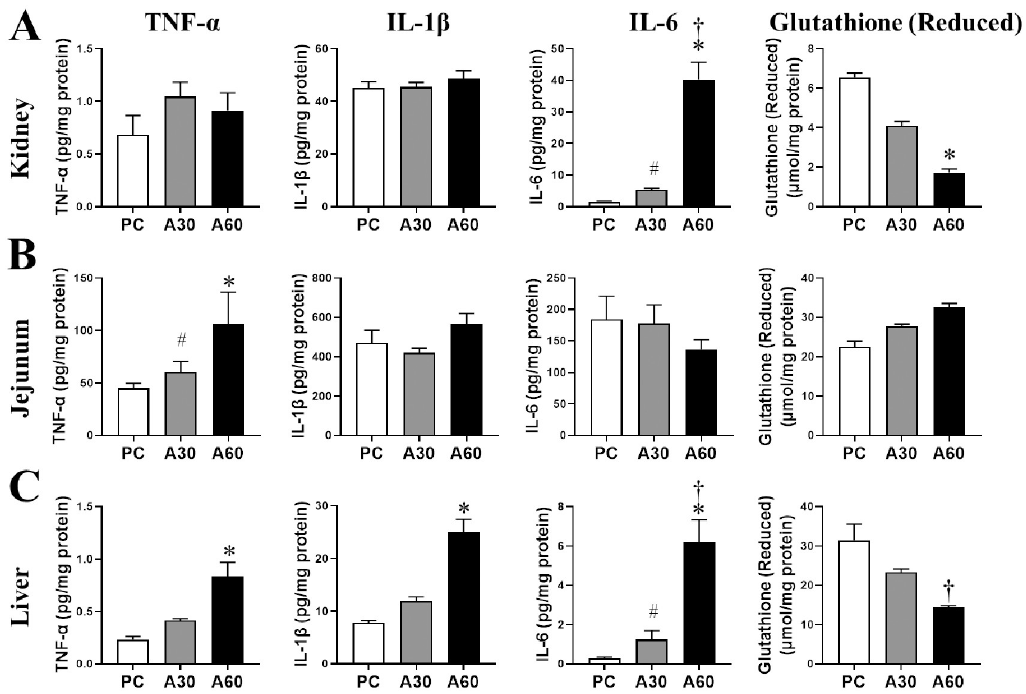
Fig 5. Local tissue inflammatory response and oxidative stress in swine undergoing cREBOA. Data are presented as mean ± SEM and were statistically analyzed using two-tailed Mann-Whitney test. # p < 0.05, A30 vs . PC; � p < 0.05, A60 vs . PC; † p < 0.05, A60 vs .